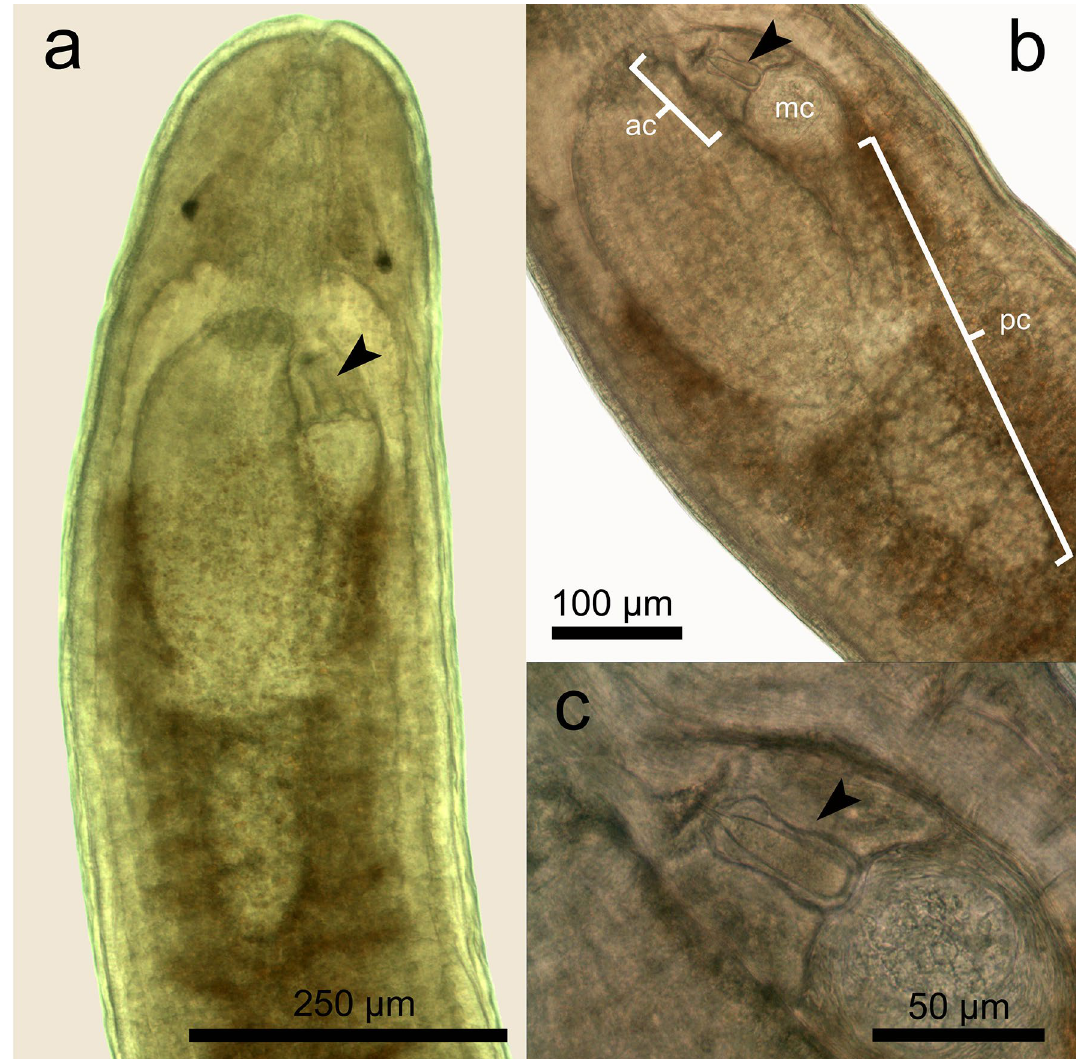
Figure 6. Photographs of anterior body section of Carcinonemertes camanchaco sp. nov ( a ); showing details of proboscis chamber, median chamber, and anterior chamber ( b ) and stylet ( c